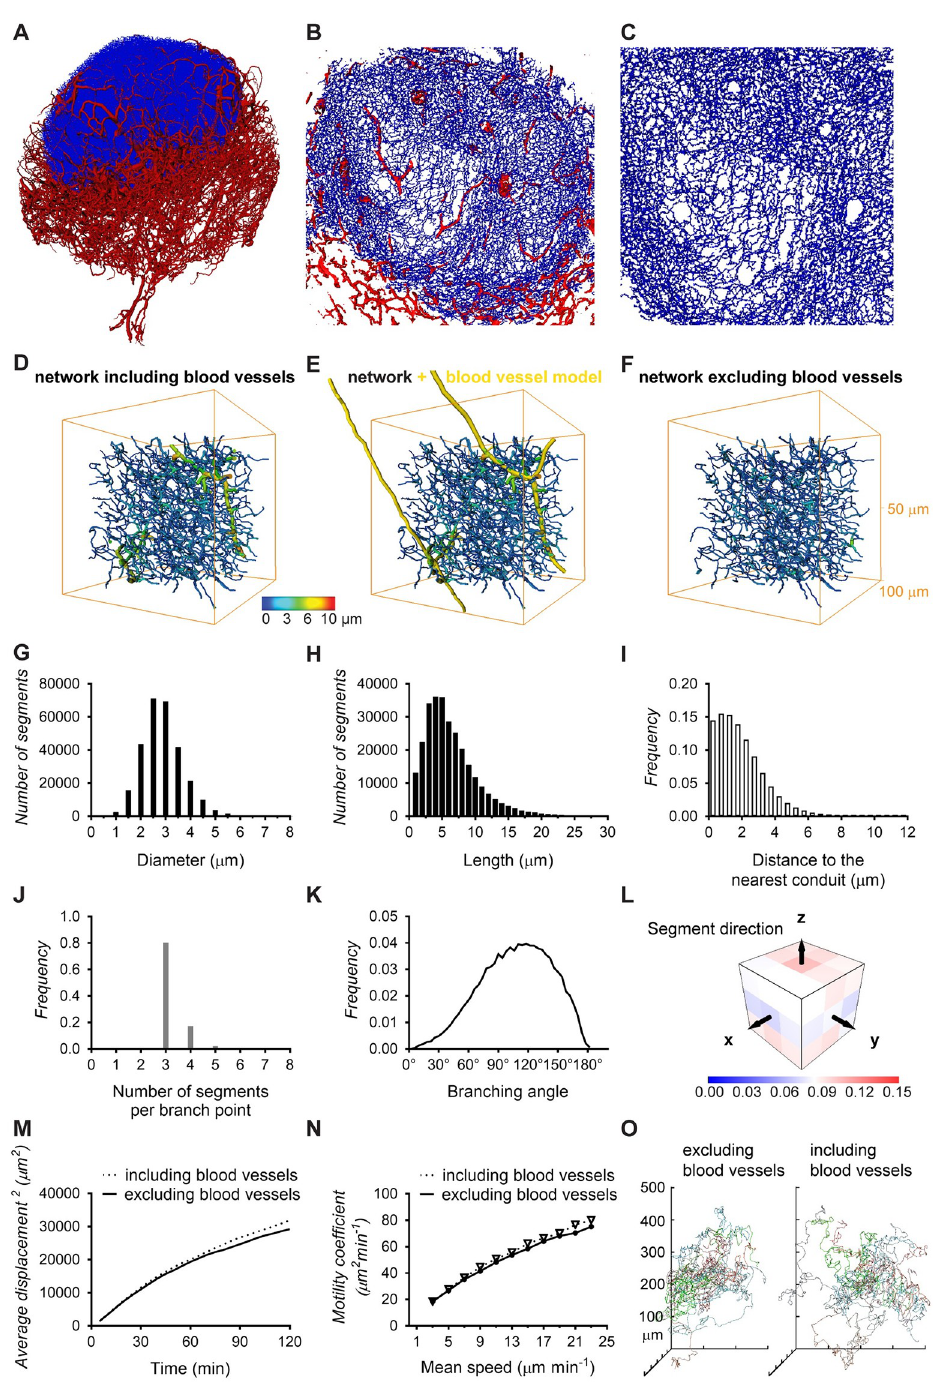
Fig 2. Network topology of the LN conduits in the TCZ. Deploying custom-developed image-processing tools, a description of the conduit network in terms of nodes and links was generated from the 3D image data and used to estimate network parameters. Three-dimensional projections of the blood vasculature (red) and the conduit network in the TCZ (blue) as a whole (A) and magnified views of the TCZ (B, C) expose the complexity and the high level of detail in this data set. The full conduit data include large segments with diameters over 5 μ m (D), but these represent blood vessels as the overlay with the blood vessel model (yellow) indicates (E). A blood vessel-free conduit network (F) was obtained by removing the majority of blood vessels from the 3D image prior to the network extraction in a semi- automated process. This TCZ conduit network excluding blood vessels was employed to calculate the distribution